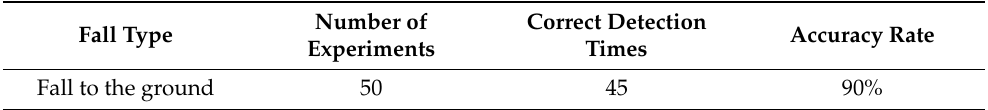
Table 2. Accuracy rate of fall